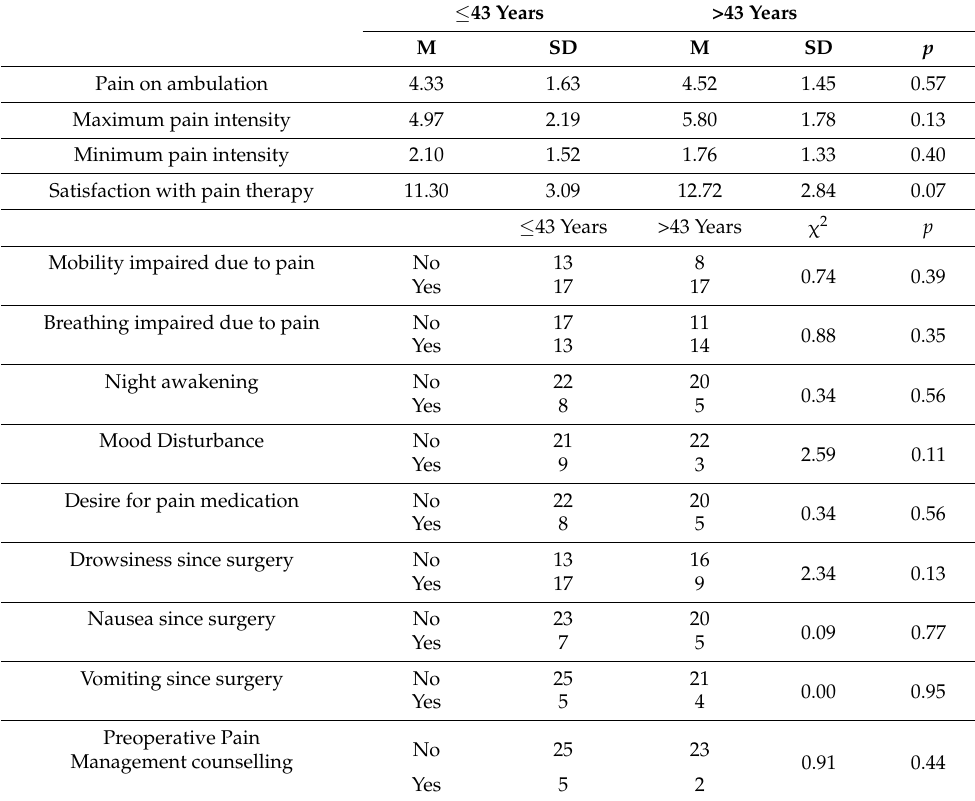
Table 3. Relation between outcome parameters and